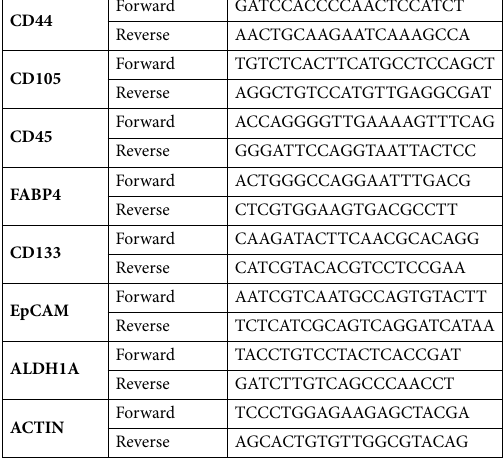
Table 1. Sequences of the primers used for RT-PCR in this